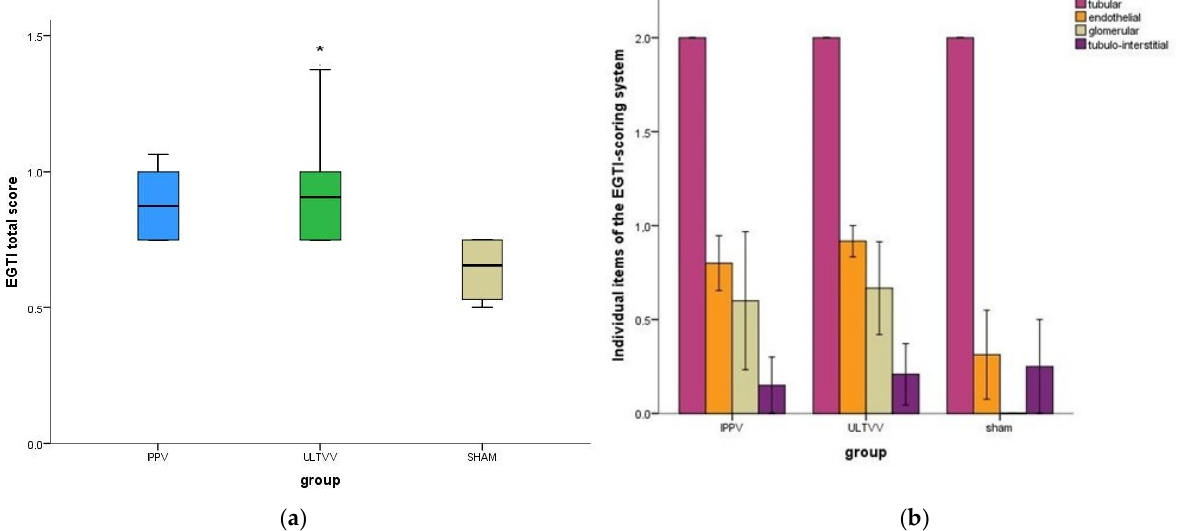
Figure 3. Histopathological scoring of the kidney ( a ) EGTI total score. ( b ) Individual items of EGTI score. Mean (± 1SE). * indicates p < 0.05 ULTVV vs. sham treatment. IPPV: Intermittent positive pressure ventilation. ULTVV: Ultra-low tidal volume ventilation. EGTI score: endothelial, glomerular, tubular and tubulo-interstitial damage score.